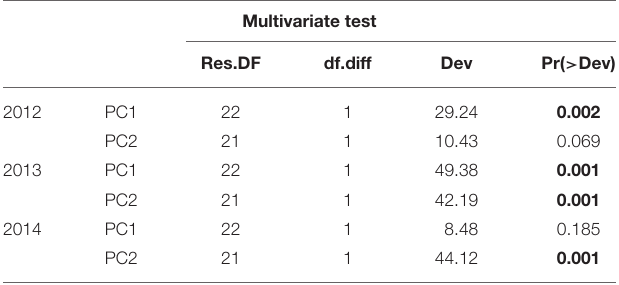
TABLE 4 | Results of multivariate GLMs between PC1 and PC2 of environmental water data showing the relationship between water quality and benthic community composition for 2012, 2013, and